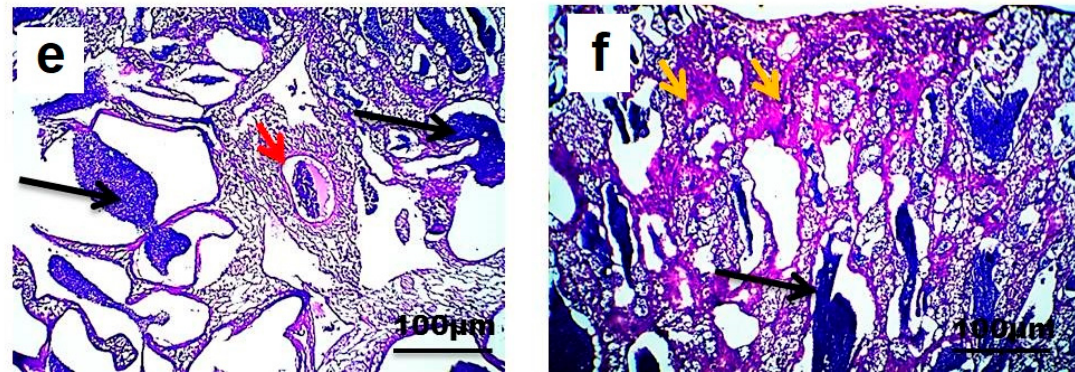
Figure 5. Microscopic pictures of testes of Nile tilapia from the reference site (RS): ( a , c – e )—show accumulation of mature sperms in the lumen of the testicular lobule (black arrows) with vacuolated seminiferous epithelium (arrowheads), ( e )—congestion (red arrow) and ( b , f )—slightly increased amount of interstitial of connective tissue (orange arrows). hematoxylin and eosin (H&E), × 100: ( a , c , e , f ) and × 400: ( b , d ).